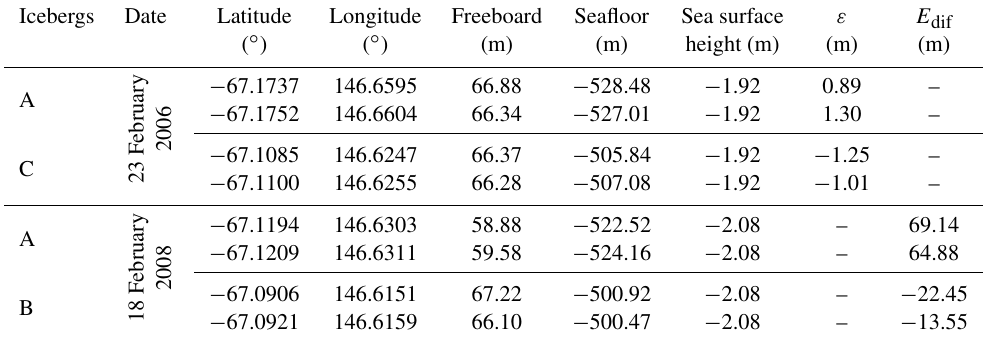
Table 1. Statistics of icebergs used to invert FAC with a least-square method and validation of grounding iceberg detection using this FAC. Icebergs A, B, and C are the same as what are used in Figs. 4 and S1. The measurements from icebergs A and C in February 2006 are used to derive the FAC with a least-squares method. However, the measurements from Icebergs A and B in 2008 are used for validation. Icebergs Date Latitude Longitude Freeboard